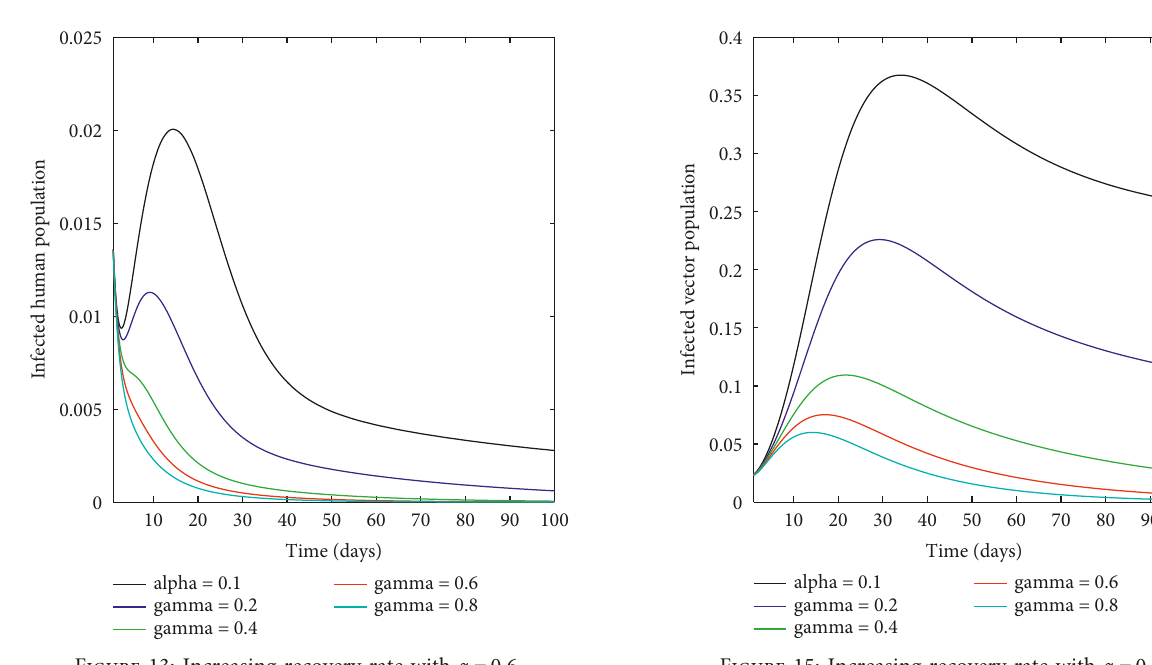
Figure 13: Increasing recovery rate with α � 0.6.